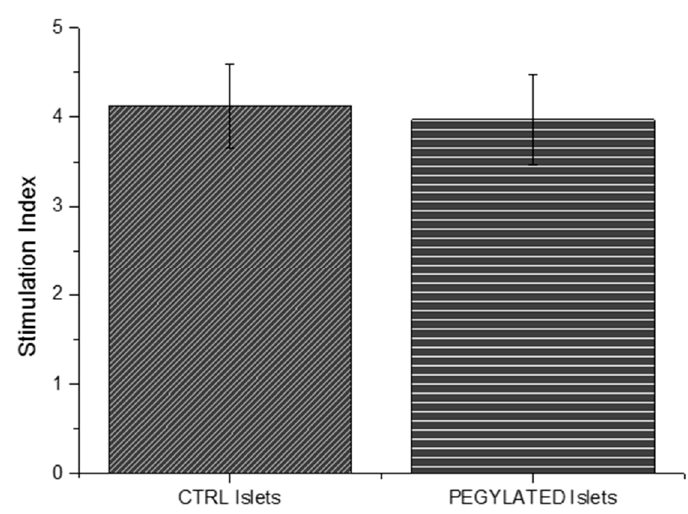
Figure 11. Results of glucose-stimulated insulin secretion (GSIS) assay on encapsulated islets compared to control islets on day 1 after encapsulation, for which the glucose stimulation index (SI) is the ratio of stimulated to-basal insulin secretion (n ≥ 5).